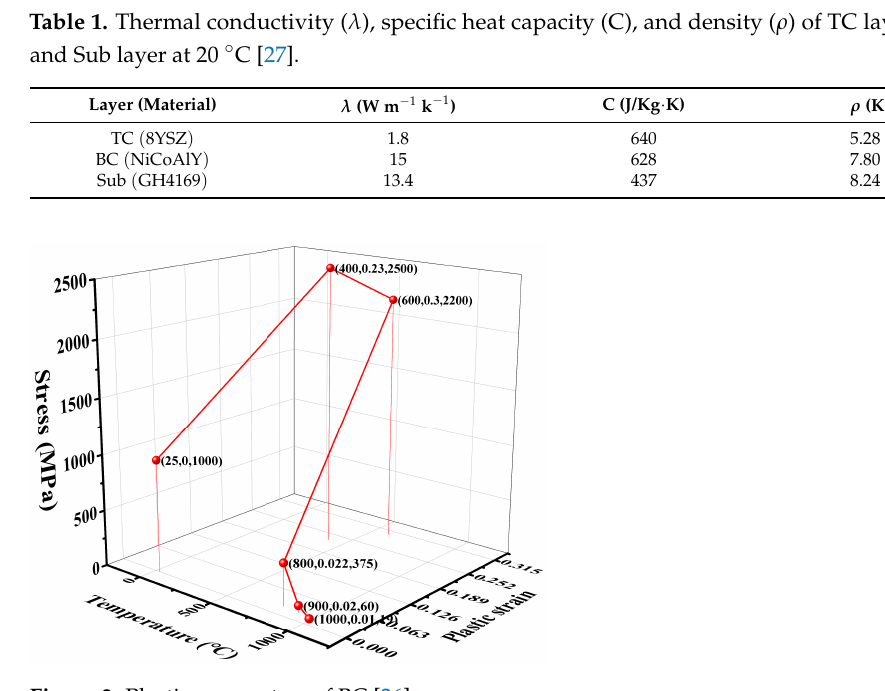
Figure 3. Plastic parameters of BC [26].